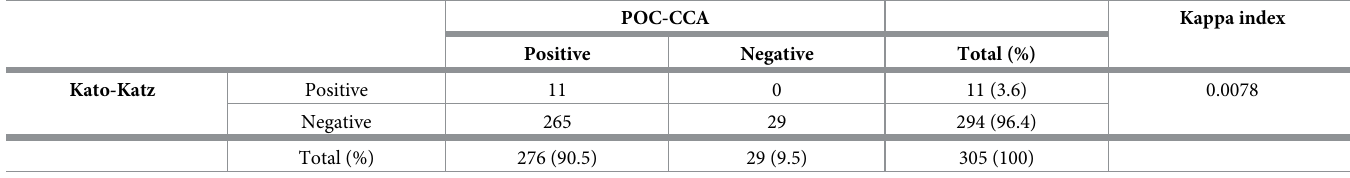
Table 2. Concordance between Kato-Katz and POC-CCA (trace as positive) for S . mansoni infection.